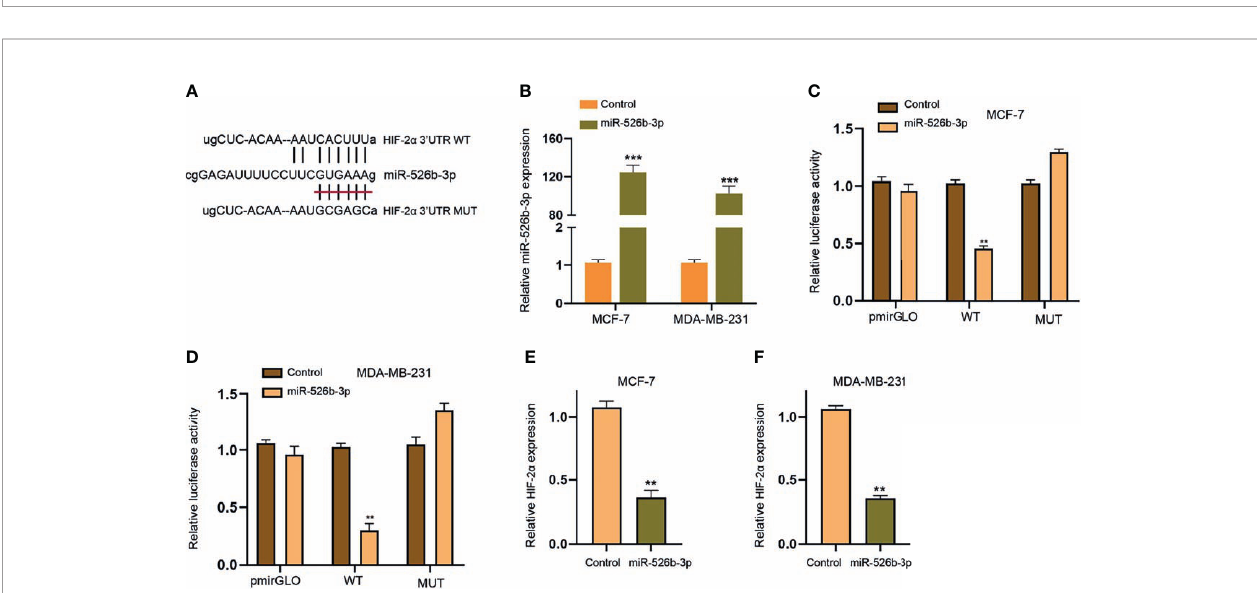
FIGURE 6 | MiR-526b-3pcantargetHIF-2 a inbreastcancer cells. (A) Thebindingsite(WT) andmutantbindingsite(MUT)ofHIF-2 a 3 ′ UTR withmiR-526b-3pwasshown. (B – F) TheMCF-7andMDA-MB-231cellsweretransfectedwithmiR-526b-3pmimic. (B) The expressionofmiR-526b-3pwasvalidatedbyqPCR. (C, D) Theluciferaseactivityof HIF-2 a 3 ′ UTRwas detectedbyluciferasereporter geneassays. (E, F) TheexpressionofHIF-2 a wasassessedbyqPCR. Dataaremean± SD: ** p < 0.01,*** p